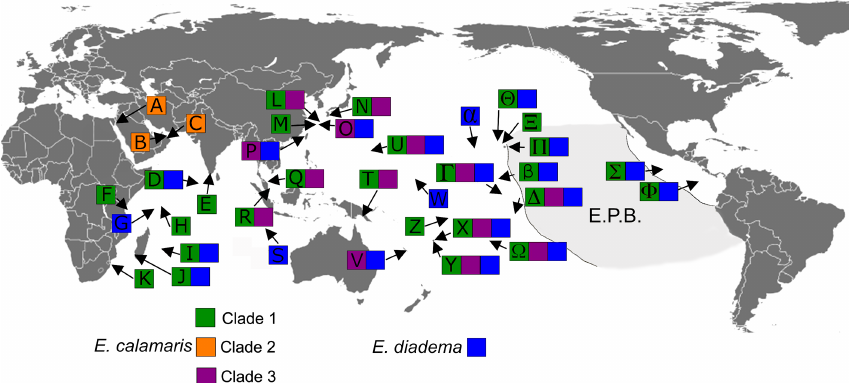
Figure 2. Distribution of clades of Echinothrix . Letter refers to locality, colour to the clade. E.P.B. = Eastern Pacific Barrier. A: Dahab, Egypt, Gulf of Aqaba (28.5236° N, 34.5301° E); B: Muscat, Oman, Gulf of Oman (23.9871° N, 58.1859° E); C: Al Fahal Island, Gulf of Oman (23.6822° N, 58.5020° E); D: Ari Atoll, Maldives (3.8825° N, 72.8340° E); E: Kanyakumari, India (8.0798° N, 77.5276° E); F: Zanzibar Island, Tanzania (6.1374° S, 39.1684° E); G: Amirante Islands, Seychelles (6.1554° S, 52.8513° E); H: Seychelles (4.7178° S, 55.4260° E); I: Réunion Island (21.0271° S, 55.7966° E); J: Tuléar, Madagascar (23.3833° S, 43.6667° E); K: Sodwana Bay, South Africa (27.5187° S, 32.6915° E); L: Sesoko Island, Japan (26.6333° N, 127.8667° E); M: Akajima Island, Japan (26.2042° N, 127.2876° E); N: Kyushu, Japan (31.0553° N, 130.3640° E); O: Ishigaki Island, Japan (24.46307° N, 124.2747° E); P: Kenting, Taiwan (21.9447° N, 120.7750° E); Q: Redang Island, Malaysia (5.7893° N, 103.0184° E); R: Tioman Island, Malaysia (2.8162° N, 104.1543° E); S: Cocos (Keeling) Islands (12.1889° S, 96.8197° E); T: Motupore Island, Papua New Guinea (9.5233° S, 147.2860° E); U: Pago Bay, Guam (13.4207° N, 144.7940° E); V: Noumea, New Caledonia (22.2959° S, 166.4370° E); W: Majuro Atoll, Marshall Islands (7.0915° N, 171.3772° E); X: Suva Lagoon, Fiji (18.1777° S, 178.4875° E); Y: Namatakula, Fiji (18.2372° S, 177.7845° E); Z: Upola Island, Samoa (13.7835° S, 171.8589° W); α: Johnston Atoll (16.7405° N, 169.5074° W); β: Kingman Reef (6.4188° N, 162.3655° W); Ω: Rarotonga, Cook Islands (21.2142° S, 159.7126° W); Δ: Maharepa, Moorea (17.4758° S, 149.7929° W); Γ: Kiritimati Island, Kiribati (Line Islands) (1.9213° N, 157.4442° W); Θ: Oahu, Hawaii (21.2951° N, 157.8830° W); Π: Hawaii Island, Hawaii (19.7308° N, 154.9915° W); Ξ: Maui, Hawaii (20.6267° N, 156.1925° W); Σ: Clipperton Island (10.2862° N, 109.2124° W); Φ: Isla del Coco, Costa Rica (5.5360° N, 87.0244° W). The outline of this map was downloaded from Dmthoth, CC BY-SA 3.0, via Wikimedia Commons and edited in Photoshop Elements 2020.